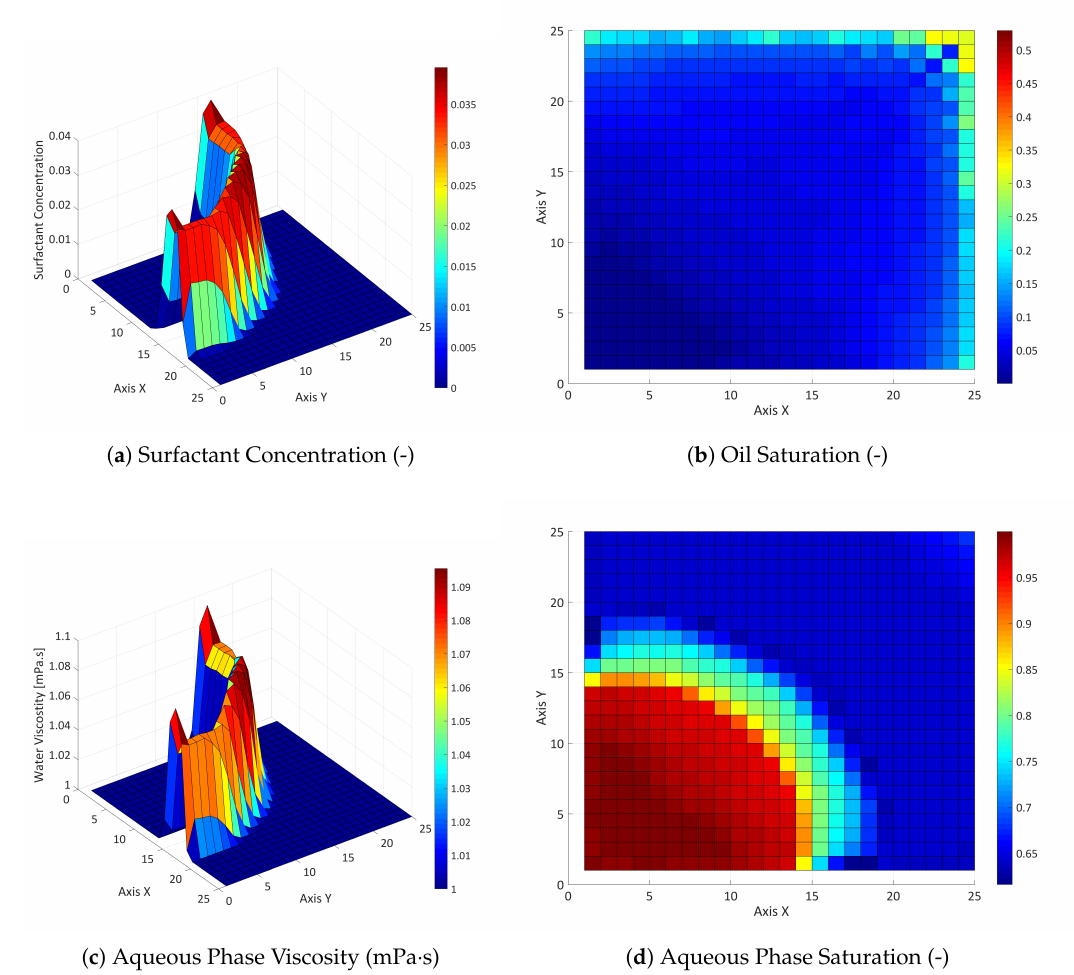
Figure 12. Surfactant concentration (after 5000 days— a ), oil saturation (after 15,000 days— b ), aqueous phase viscosity [mPa·s] (after 5000 days— c ), and auqeous phase saturation (after 5000 days— d ) profiles for a cEOR flooding with k c = 2, L a pc = 2 and L o wc =